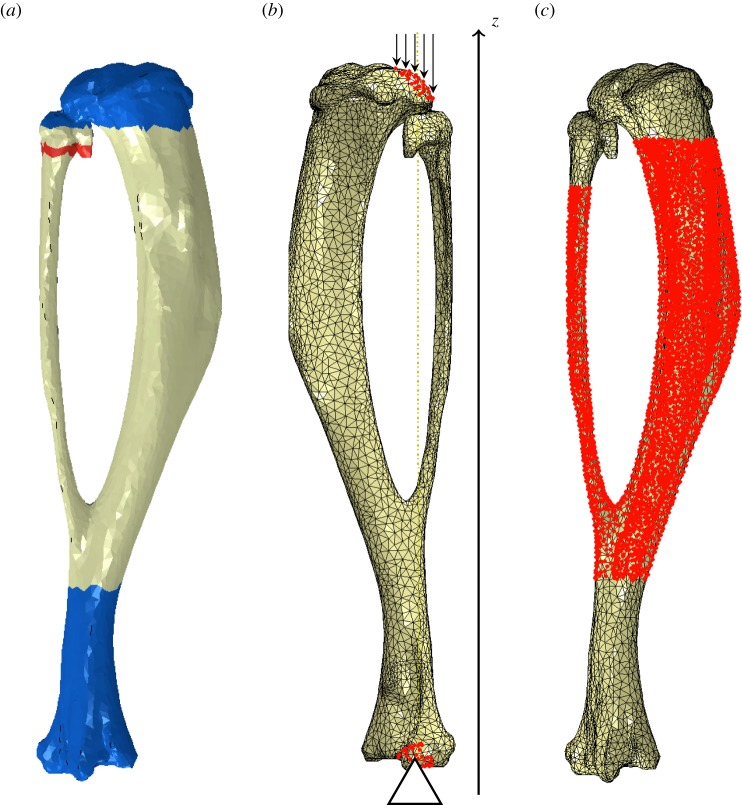
FE model used to determine the mechanical environment. (a) Medial view of the material sections considered: poroelastic cortical bone (off-white), elastic cortical bone (blue) and fibular growth plate (red). (b) Lateral view of the boundary conditions applied and vertical alignment of the model assembly with the z-direction. (c) Medial view of the region where cortical bone adaptation was considered, demarcated by the cloud of nodes highlighted in red.